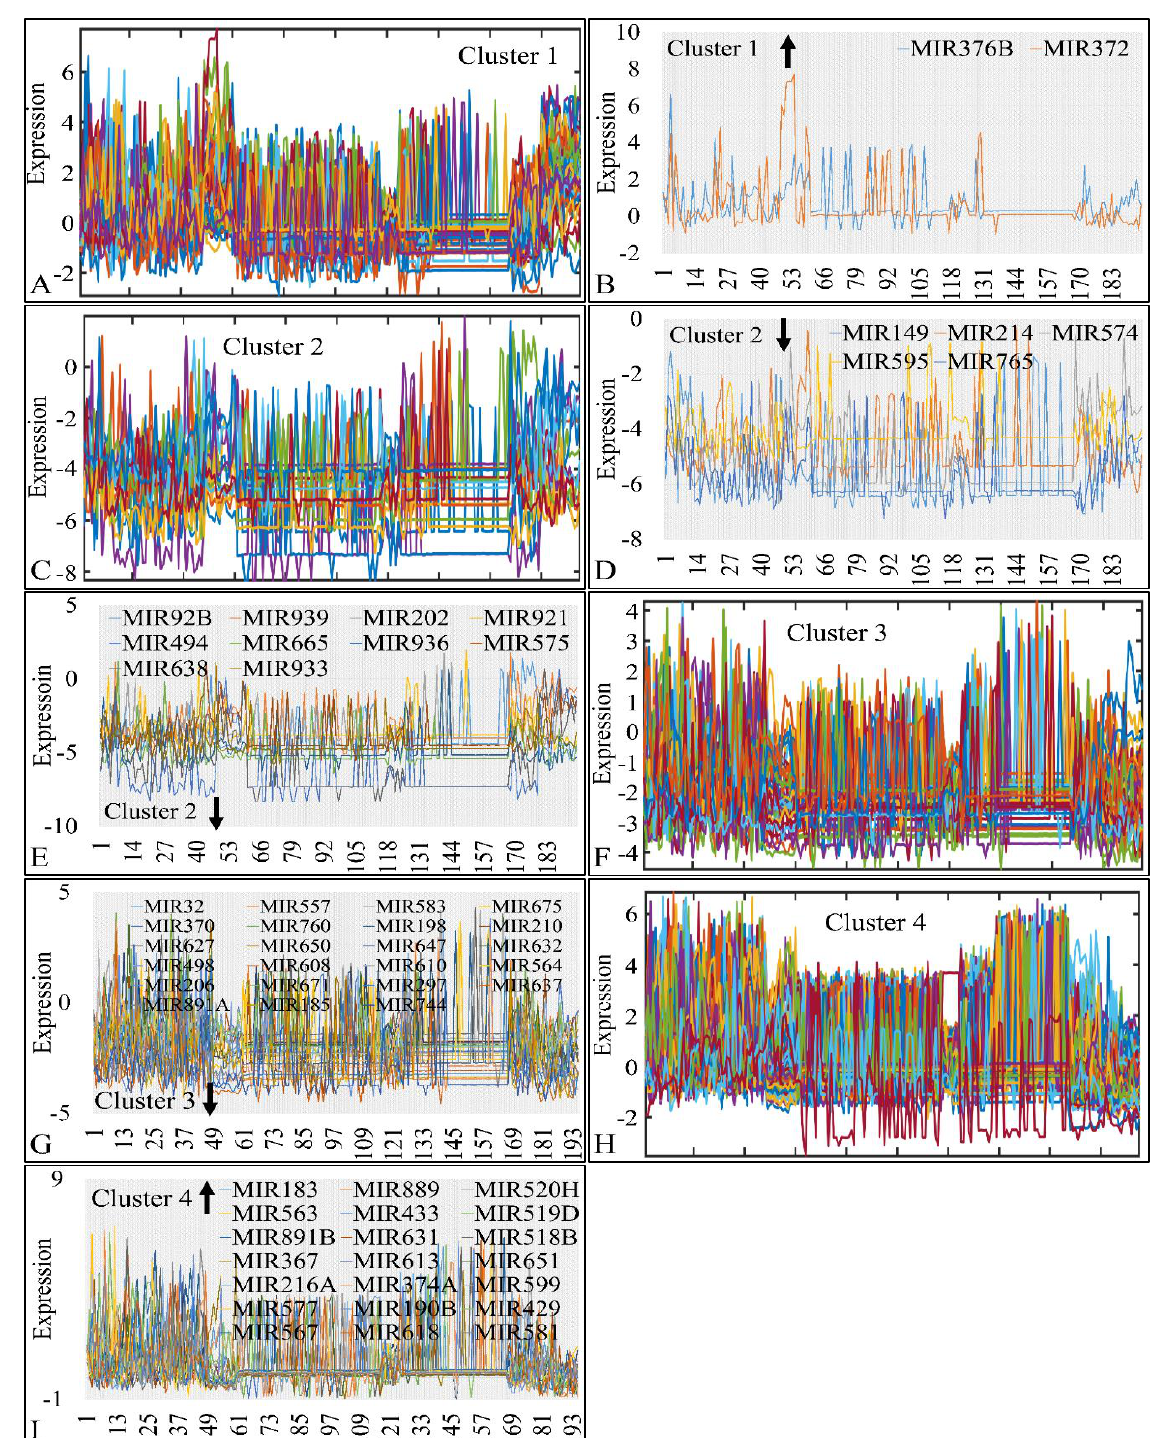
Figure 8. Common DE miRNAs across all CNS tumor samples. The co-DE miRNAs are presented in each k-means cluster (1–4). Each k-means cluster is presented separately along with the individual genes manifesting global up- or down-regulation. In particular, cluster 1 ( A ), manifested two globally up-regulated miRNAs (>75% and <100%) ( B ), cluster 2 ( C ), manifested five globally down-regulated miRNAs, which also consisted of a special case as they were down-regulated in all samples (100%) ( D ) and 10 globally down-regulated miRNAs in >90% of all samples ( E ), cluster 3 ( F ) manifested 23 globally down-regulated miRNAs (>90%) ( G ) and cluster 4 ( H ) manifested 21 globally up-regulated miRNAs (>90%) in all samples ( I ) (the arrow next to cluster number signifies the tendency of miRNAs in the respective